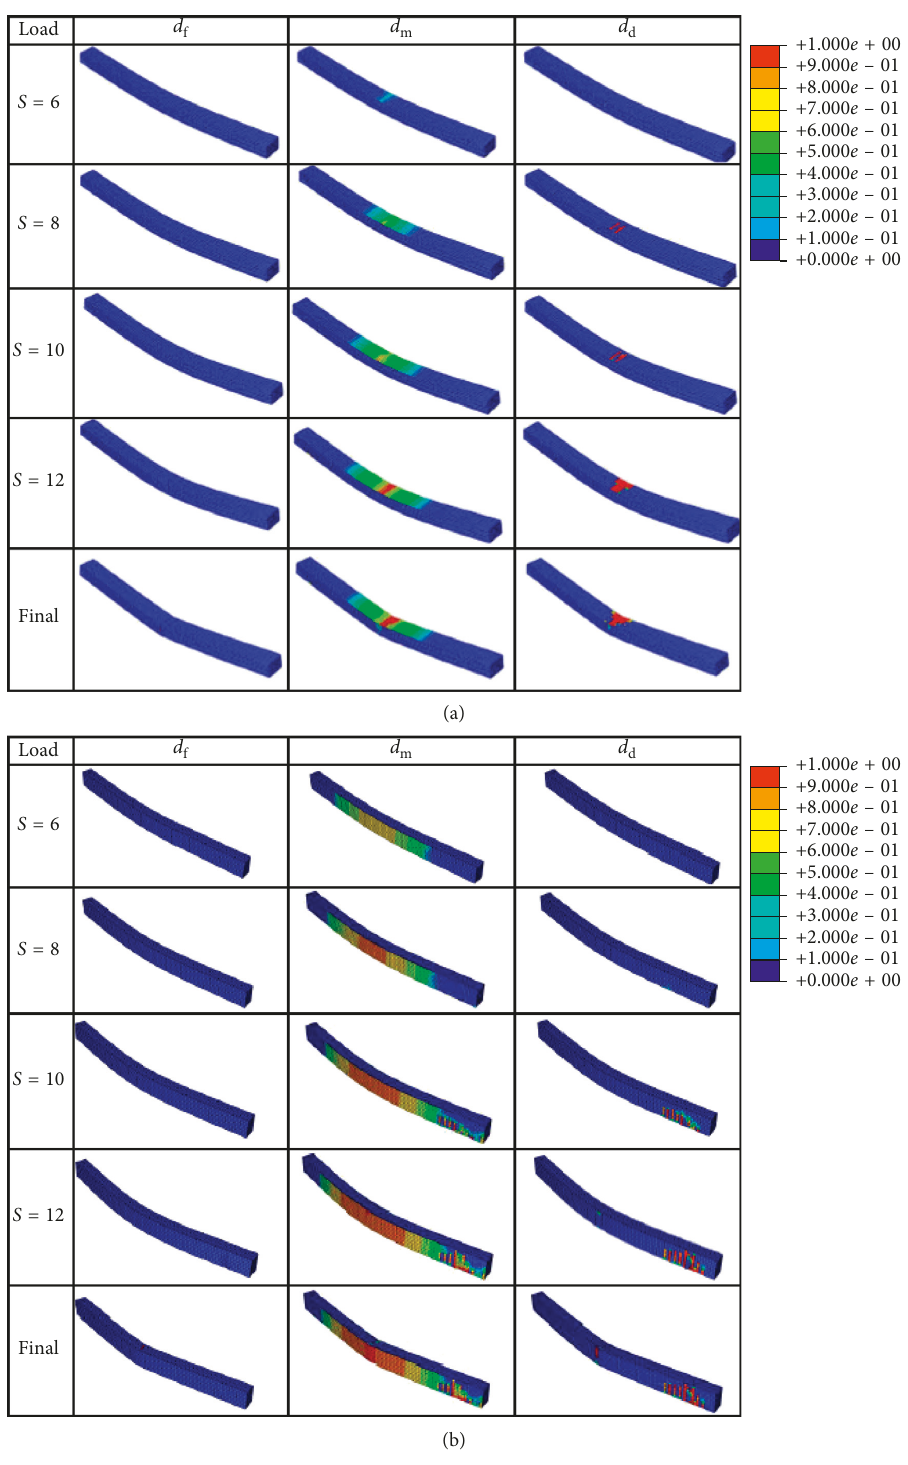
Figure 9: Failure modes of longitudinal specimens. (a) Top surface. (b) Bottom